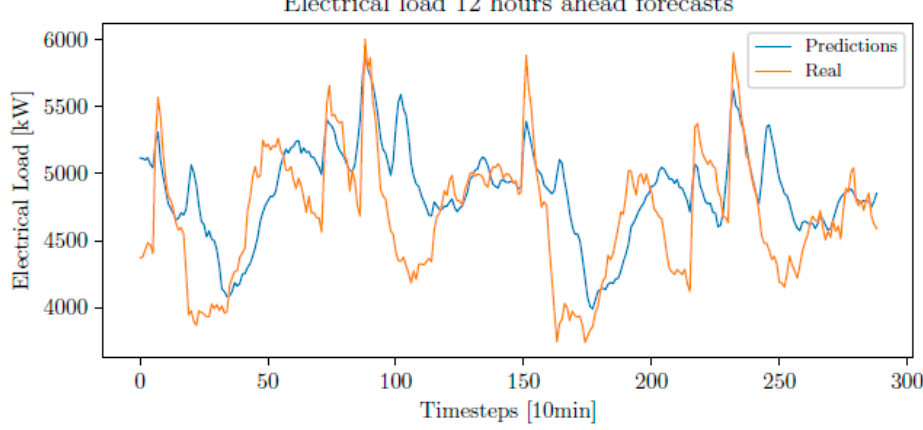
Figure 10. Twelve-hours-ahead initial forecasts.